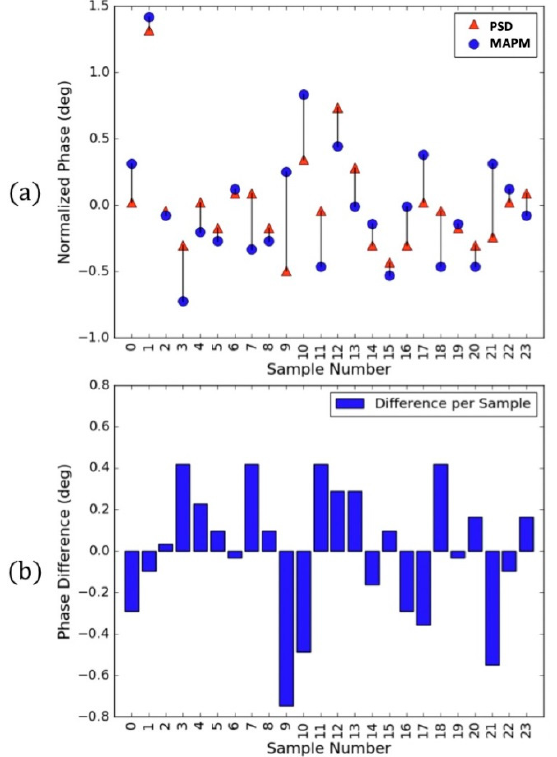
Figure 4. ( a ) The 48 MEMS mirror phase deviations as measured by the MAPM (circles) and PSD (triangles). ( b ) Normalized phase measurement differences between the MAPM and PSD at each point in ( a ) with an average difference of 0° and standard deviation of 0.3197°.